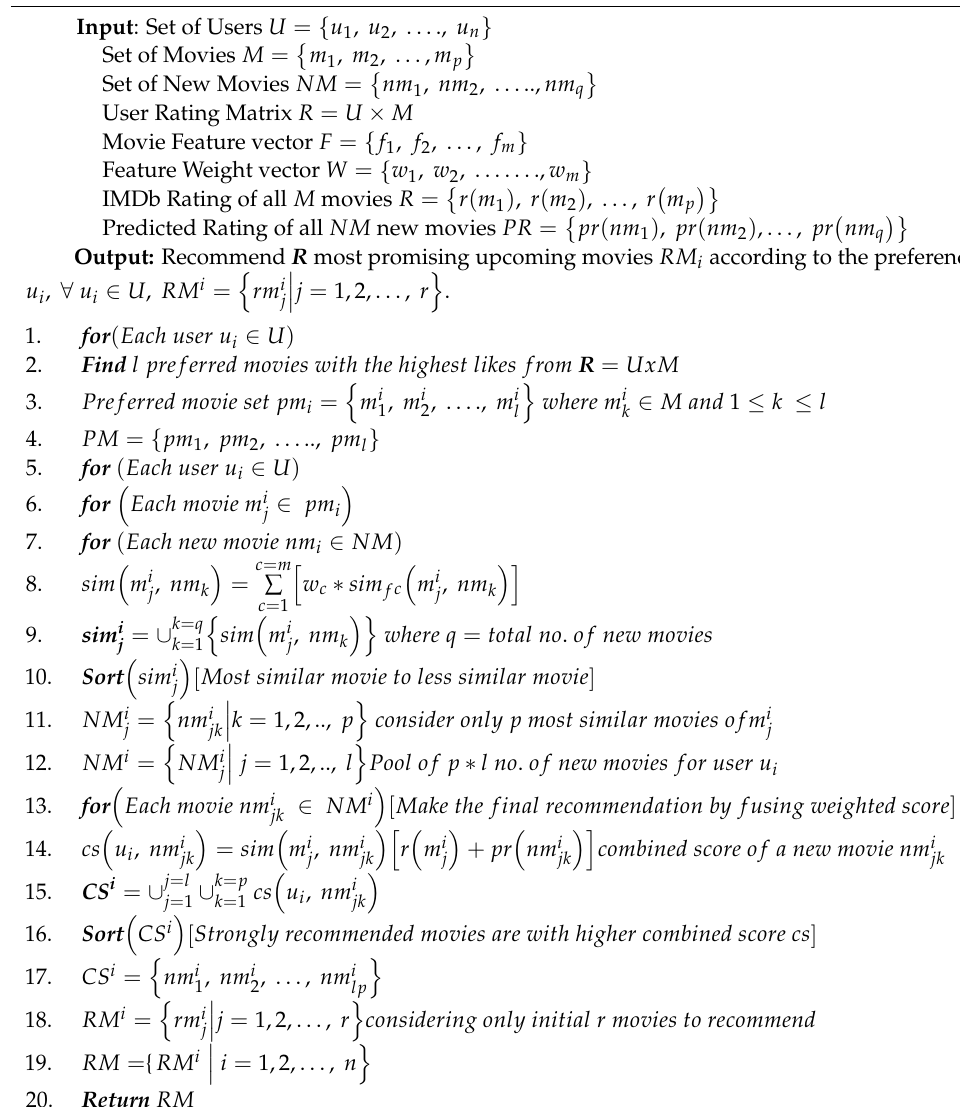
Algorithm 1: Hybrid Recommendation System for up-coming Movie